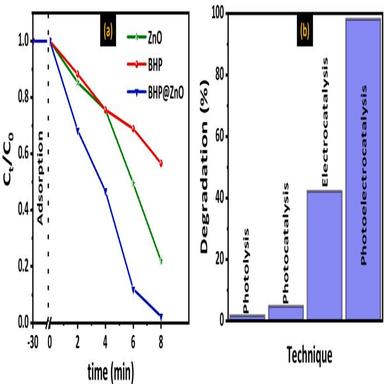
(a) Kinetics of photoelectrochemical degradation of RHB by ZnO, BHP and BHP@ZnO, (b) The degradation of RhB using the different techniques during 8 min of reaction time.